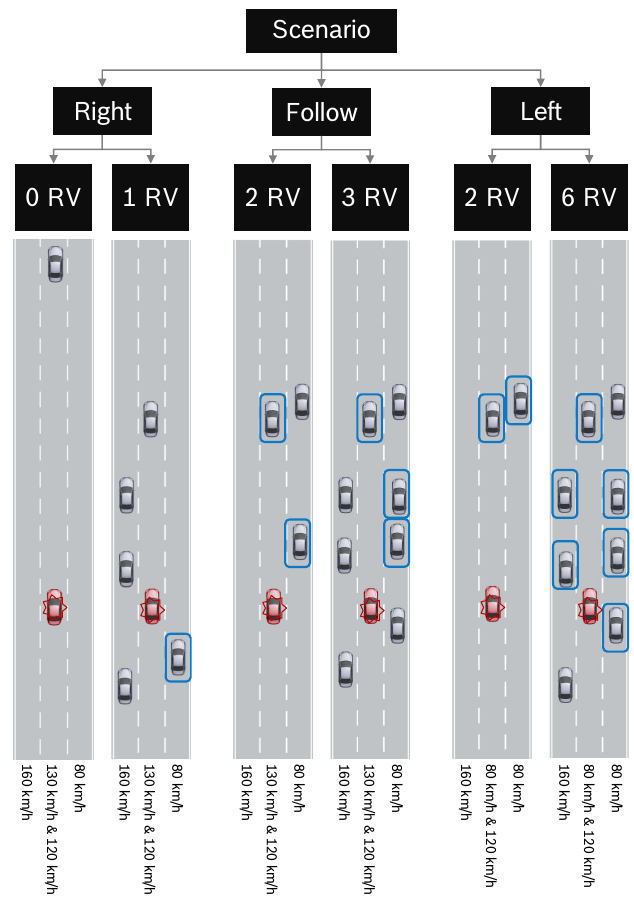
Figure 3. Traffic scenarios during the takeover request. Blue squares mark relevant vehicles in the given scenario situation, the red star marks the ego